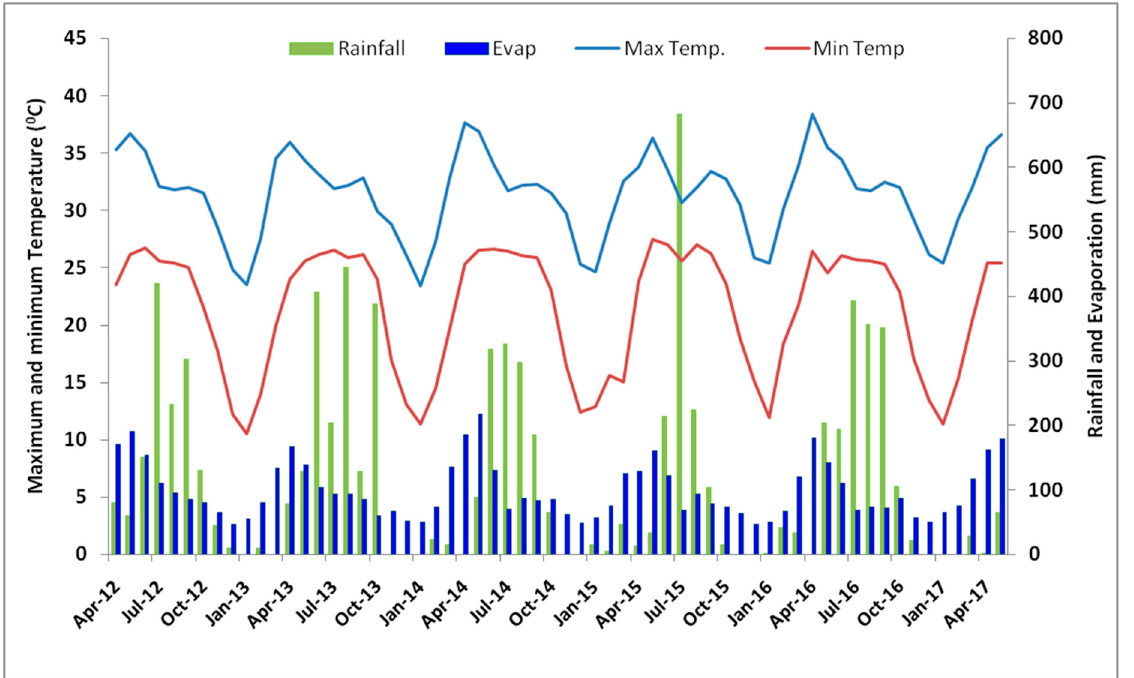
Figure 1. Monthly rainfall. Mean monthly maximum and minimum temperature and evaporation during the year of experimentation 2012–2017.